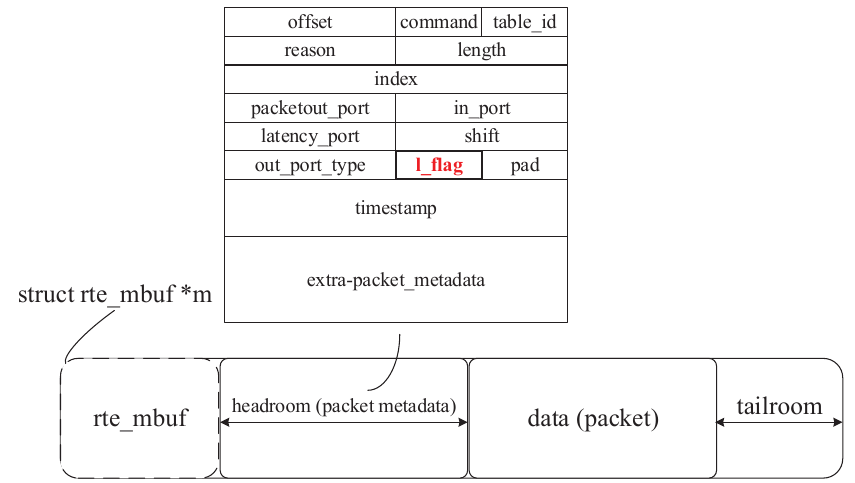
Figure 3. The structure of rte _ mbuf which stores packets and the packet